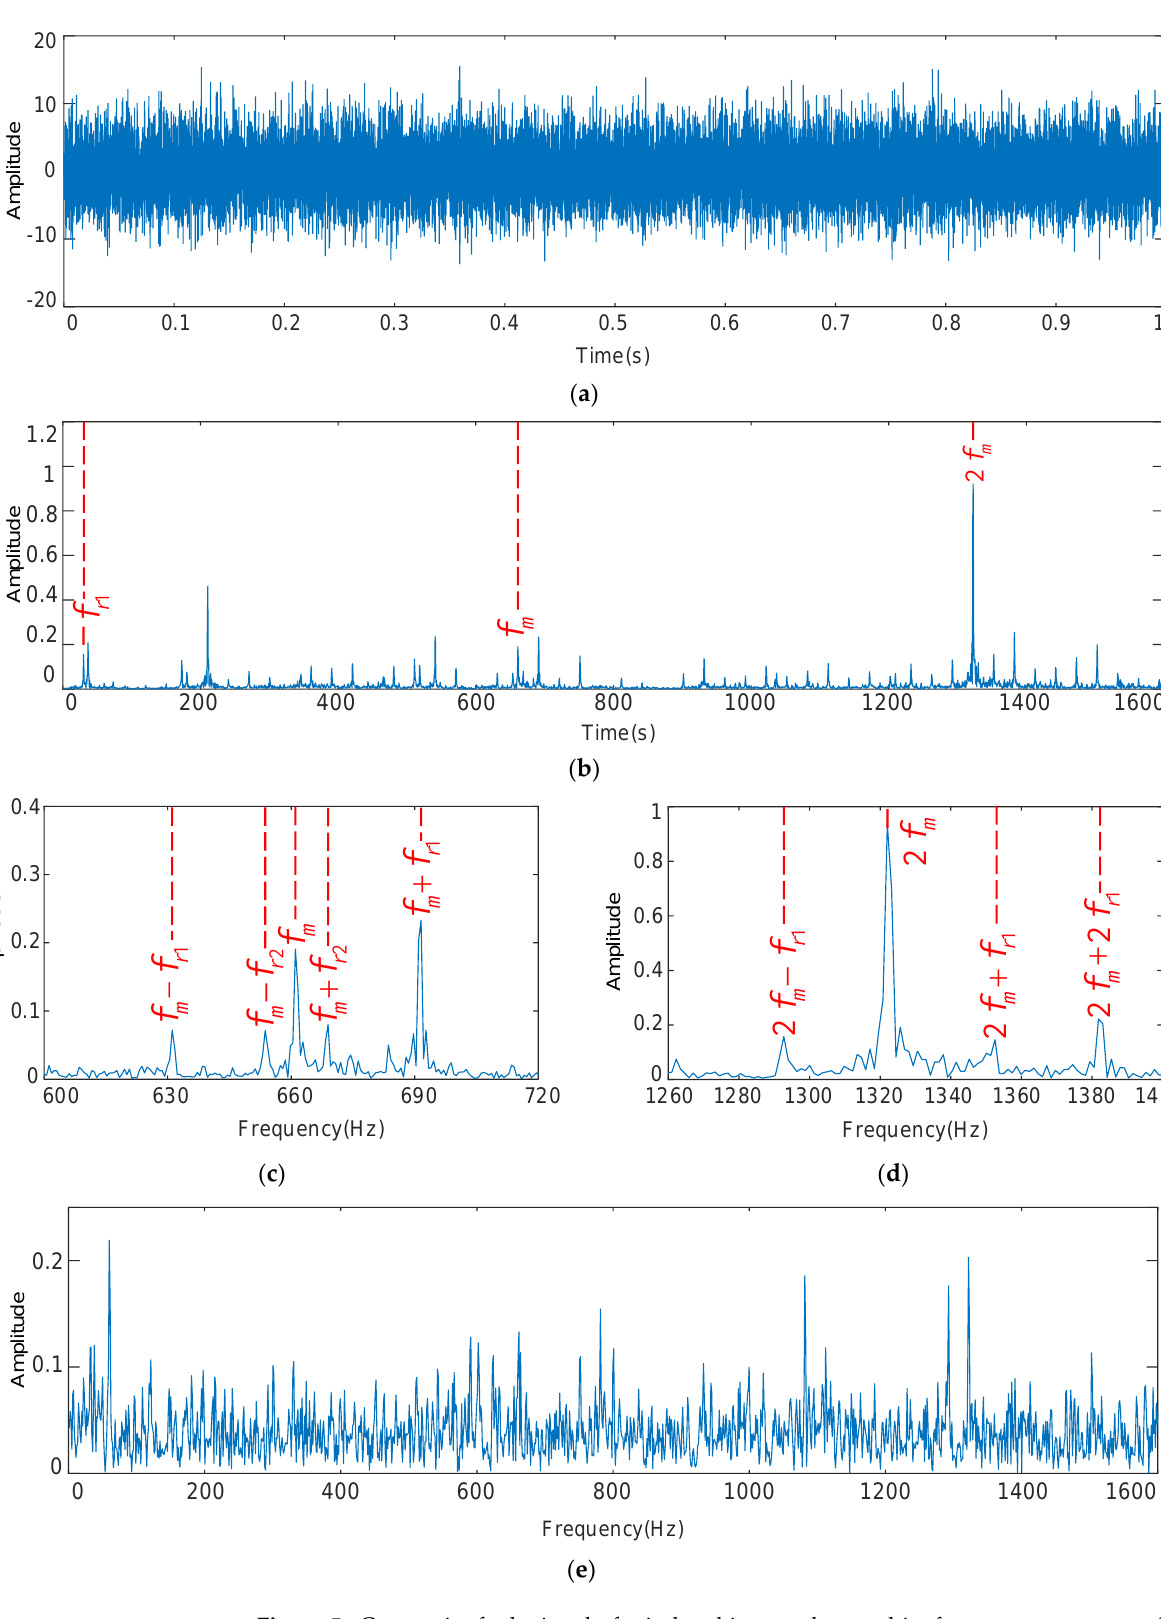
Figure 5. Composite fault signal of wind turbine gearbox and its frequency spectrum. ( a ) Time domain; ( b ) Fourier spectrum ( c ) 600 – 720 Hz spectrum amplification; ( d ) 1240 – 1400 Hz spectrum amplification; ( e ) Envelope spectrum.